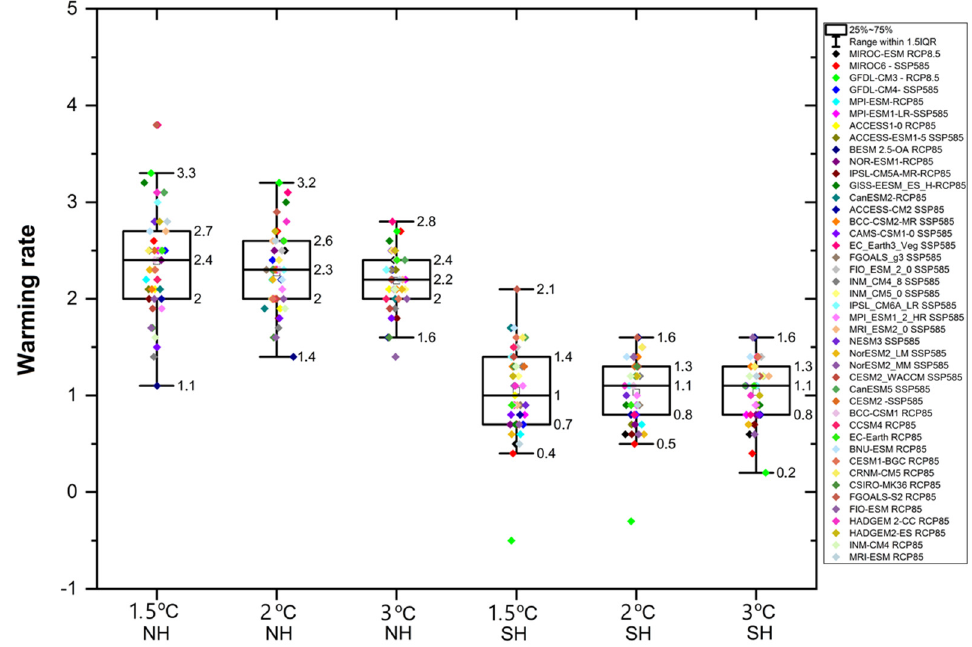
Figure 5. Warming rate of the Polar Amplification simulated by CMIP5 and CMIP6 climate models for the temperature thresholds of +1.5 °C, 2.0 °C and 3.0 °C global mean warming under RCP8.5 and SSP585 scenarios of northern (HN) and southern (SH) hemispheres high latitudes. The boxplot indicates the central 50% intermodal range (25%–75%), the median and upper and lower boundaries in the CMIP models.